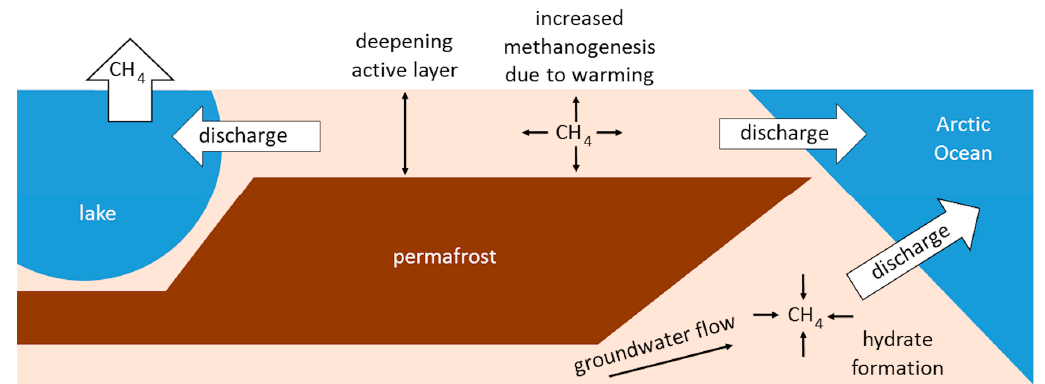
Figure 5. A conceptual model of methane–groundwater interactions. The diagram is shown as a cross-